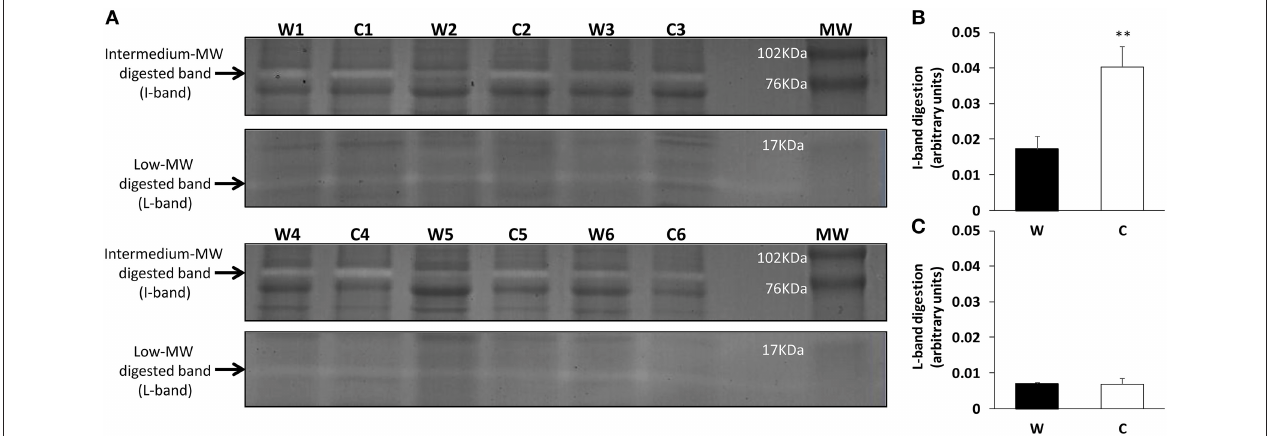
FIGURE 2 | Zymograms of skin mucus protease activities of warm (W) and cold challenged (C) gilthead sea bream. (A) Gel zymography: electrophoresis was performed on polyacrylamide (12% acrylamide) gels. Two clear digested bands were appreciated and quantified. To determine the molecular weight of the protease fractions, a commercial weight marker was used (MW-lane). The gels were cut to simplify interpretation (intact gels are provided as Supplementary Figure 2 ). (B) Intermediate band relative intensity (C) Low band relative intensity. Both the I-band and L-band intensity were calculated as arbitrary units of trypsin digestion capacity (see Supplementary Figure 2 for detailed information). ** indicates significant differences ( p < 0.01; Student’s t